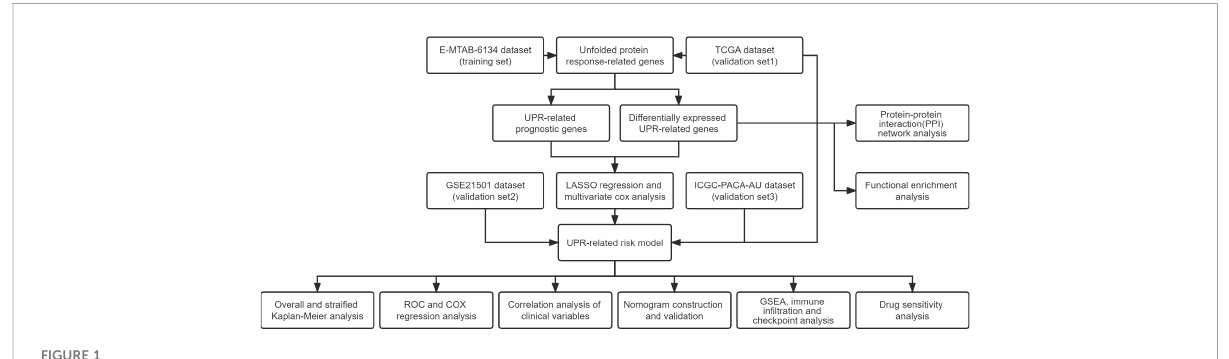
FIGURE 1 Flowchart of the study